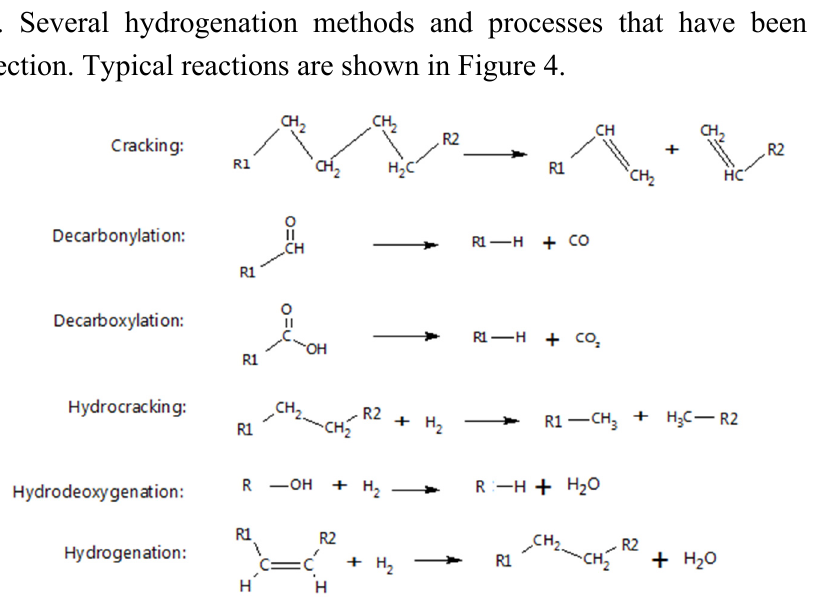
Figure 4. Typical reactions in hydrogenation and cracking processes